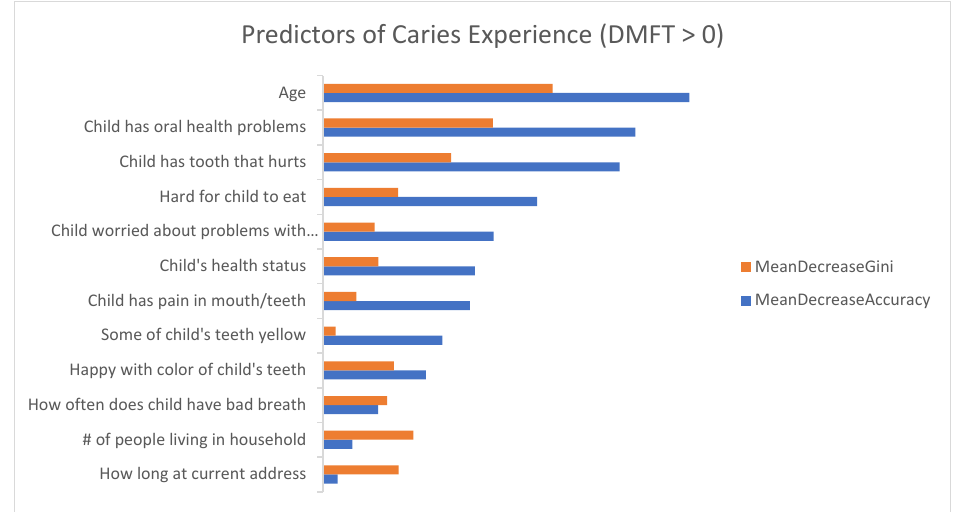
Figure 2. Demographic and oral health-related predictors of caries experience (DMFT > 0) showing both the mean decreasing of Gini (MDG) and mean decreasing of accuracy (MDA) measures. The higher the MDG and MDA, the more important the variables.